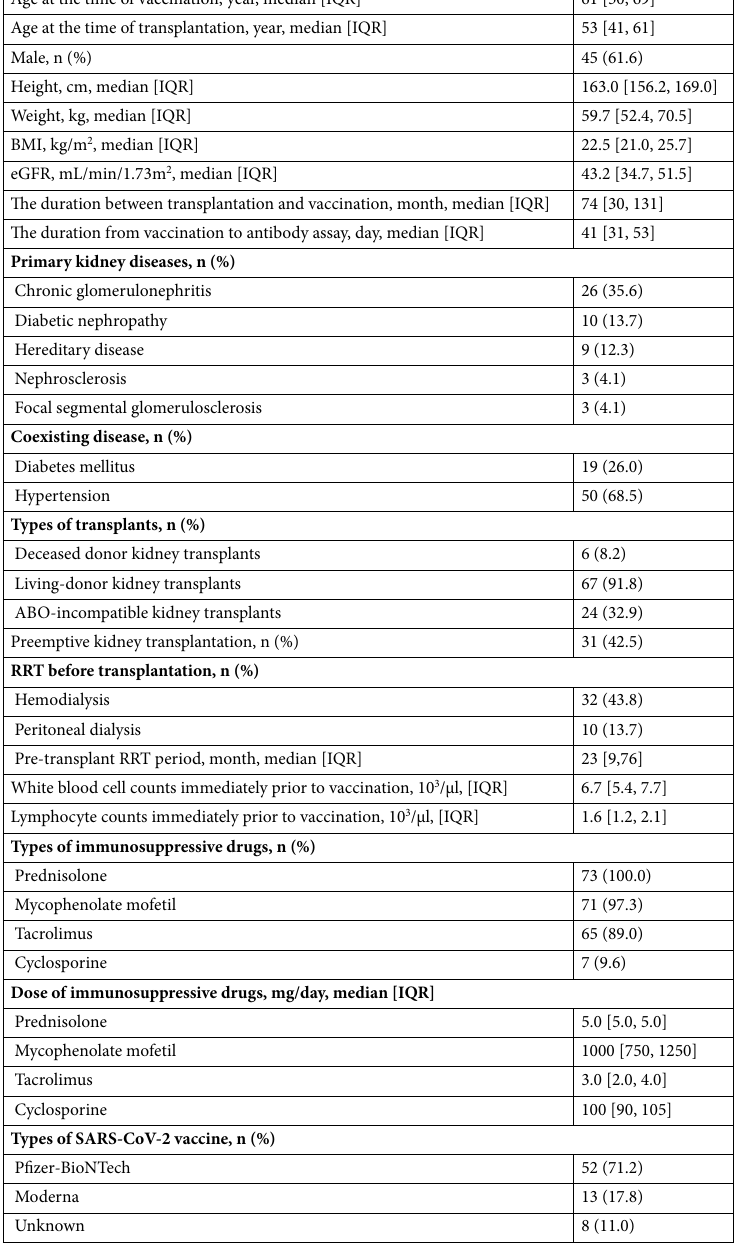
Table 1. Clinical characteristics of study participants (n = 73). IQR , interquartile range; BMI , body mass index; eGFR , estimated glomerular filtration rate; RRT, Renal replacement